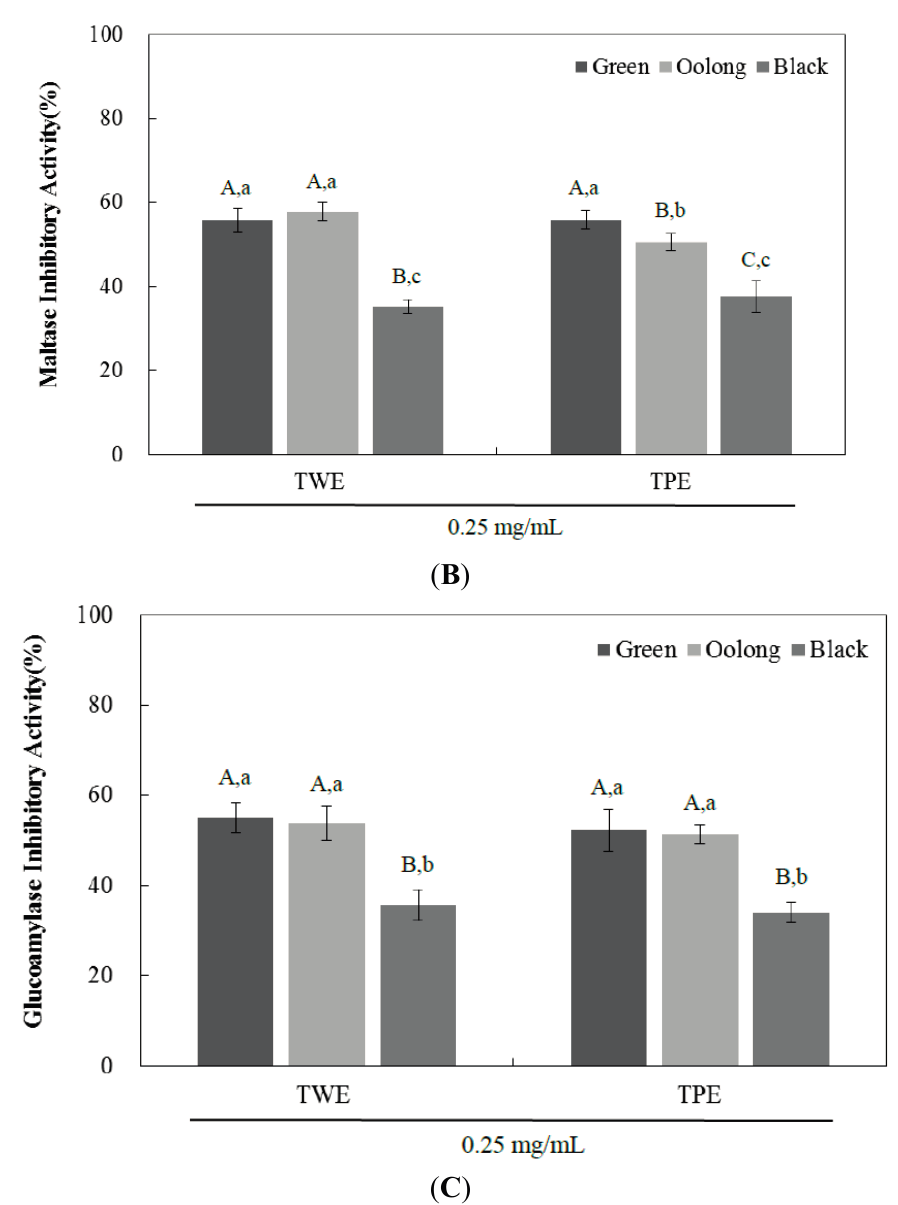
Figure 2. The inhibitory effects of tea water extract (TWE) and tea pomace extract (TPE) of green, oolong, and black tea at a concentration of 0.25 mg/mL on rat small intestinal sucrase ( A ); maltase ( B ); and glucoamylase ( C ) activities. The absorbance was measured at 530 nm and the results were expressed as mean ± SD with three independent experiments in triplicate. Different corresponding letters indicate significant differences at p < 0.05 by Duncan’s test. A − C The first letters in uppercase are different among types of tea within same extraction method and a − e the second letters in lowercase indicate significant differences among all